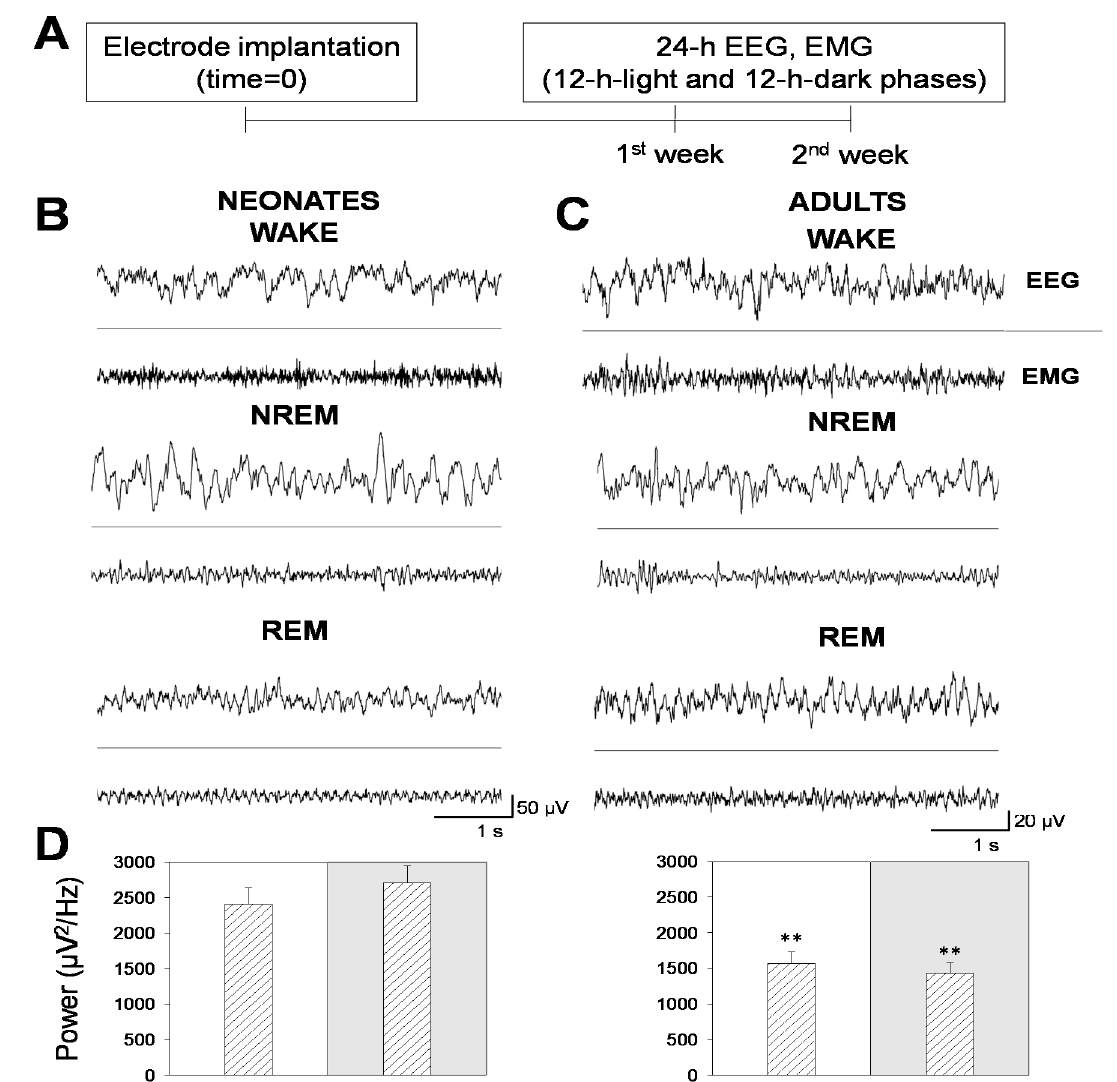
Figure 1. Electroencephalogram (EEG) and electromyogram (EMG) recordings in neonatal and adult mice. ( A ) Experi- mental design for EEG and EMG longitudinal recordings in mice. Following electrode implantation and a post-surgical recovery period, mice were recorded during two consecutive weeks in continuous 48 h recording sessions per week. ( B , C ) Representative 5 s EEG and EMG traces of behavioral states (wakefulness, non-rapid eye movement (NREM), and rapid eye movement (REM) sleep in neonatal (left) and adult (right) mice. ( D ) Bars represent the total power within the 0–100 Hz. frequencies in neonatal (left panel) and adult (right panel) mice. White or gray backgrounds represent 12 h-light or 12 h-dark phase, respectively. The graphs below show the total power as a function of the recording time in a 24 h period. Data shown as mean ± SEM of either 18 or 27 recordings retrieved from 6 neonatal or 11 adult mice, respectively. Asterisks denote significant differences between neonatal and adult mice: ** p < 0.01; Unpaired t -test.